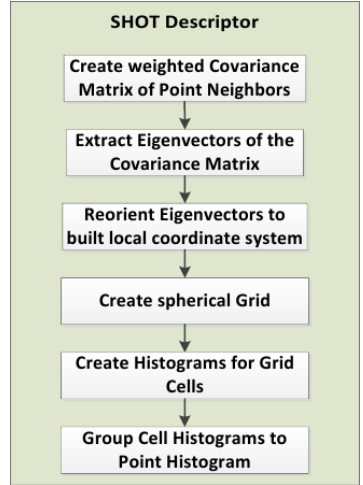
Figure 9: SHOT descriptor computation for one point An eigenvalue decomposition of the covariance matrix results in three orthogonal eigenvectors that define the local coordinate